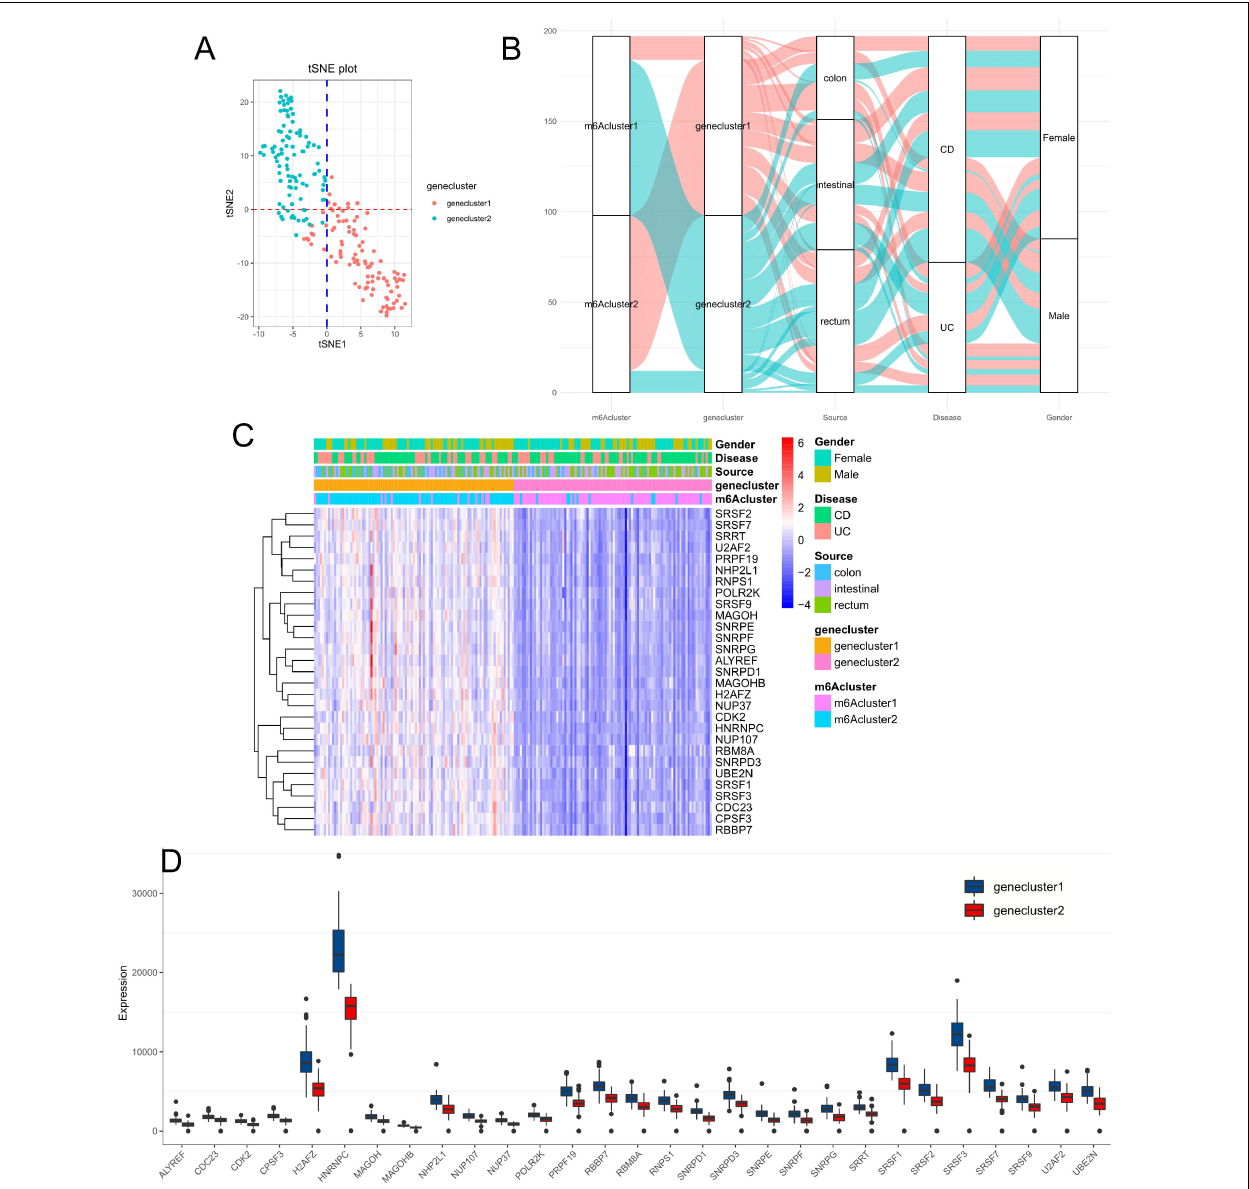
FIGURE 5 | Consensus clustering for m 6 A phenotype–related hub genes with the characteristics of IBD patients. (A) Clustering the samples with the tSNE method. (B) Alluvial diagram showing the changes of m 6 Aclusters, disease subtype, location, gender, and gene clusters. (C,D) The expression of 29 hub genes between genecluster1 and